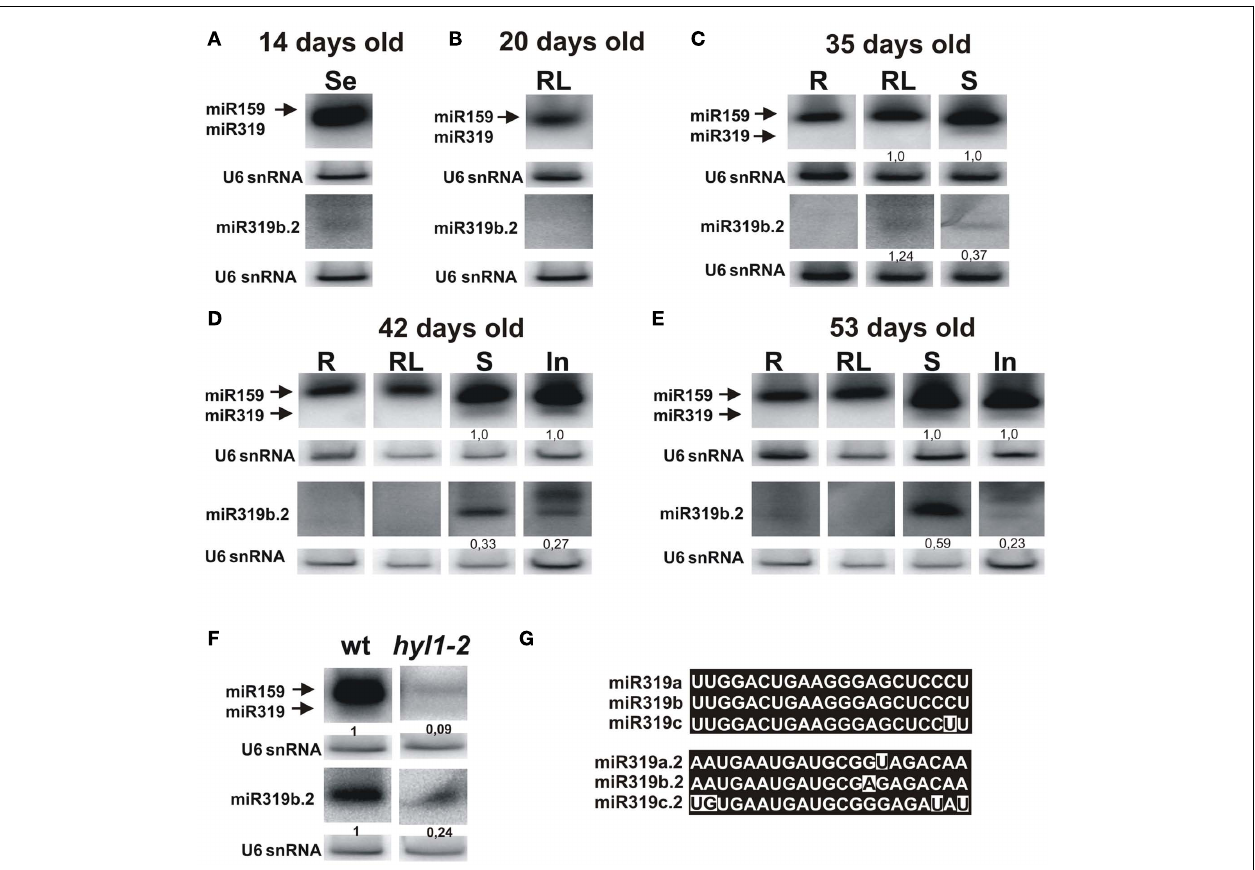
RNA isolated from the stems of 42-day-old plants.The ratio between 319b and 319b.2 signals is indicated in (C–E) , and between miR319b or miR319b.2 in wild type and hyl1-2 mutant plants in (F) . For better visualization of miR319b.2 hybridization signals, these blots were longer exposed than in the case of miR319b.The probe for U6 snRNA was used as RNA loading control. ( G ) Shows nucleotide sequences of miR319a/b/c, and miR319a.2/b.2/c.2,